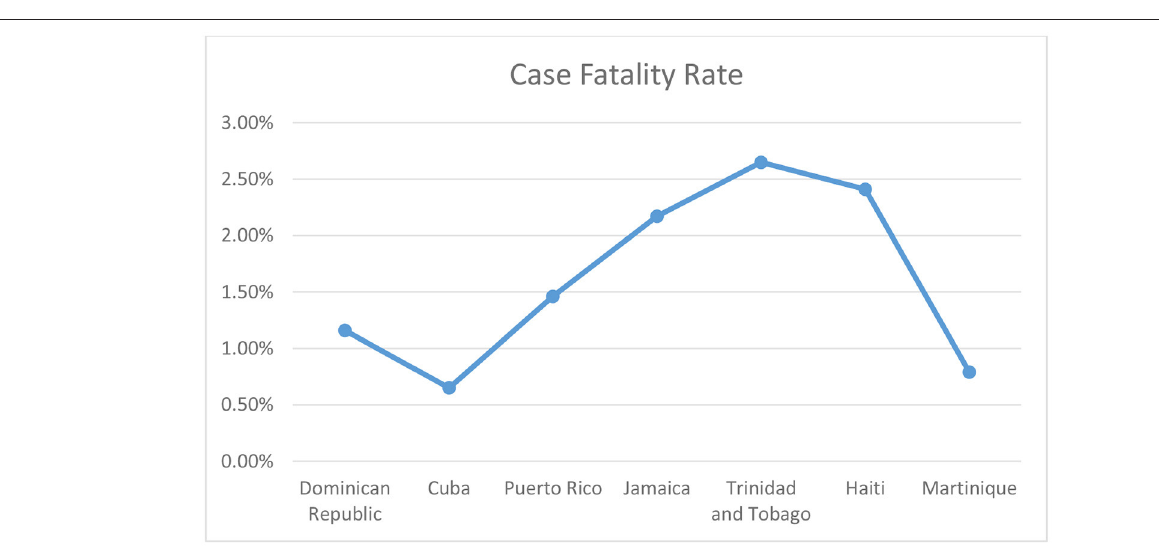
FIGURE 2 | The Caribbean regions case fatality rate as of December